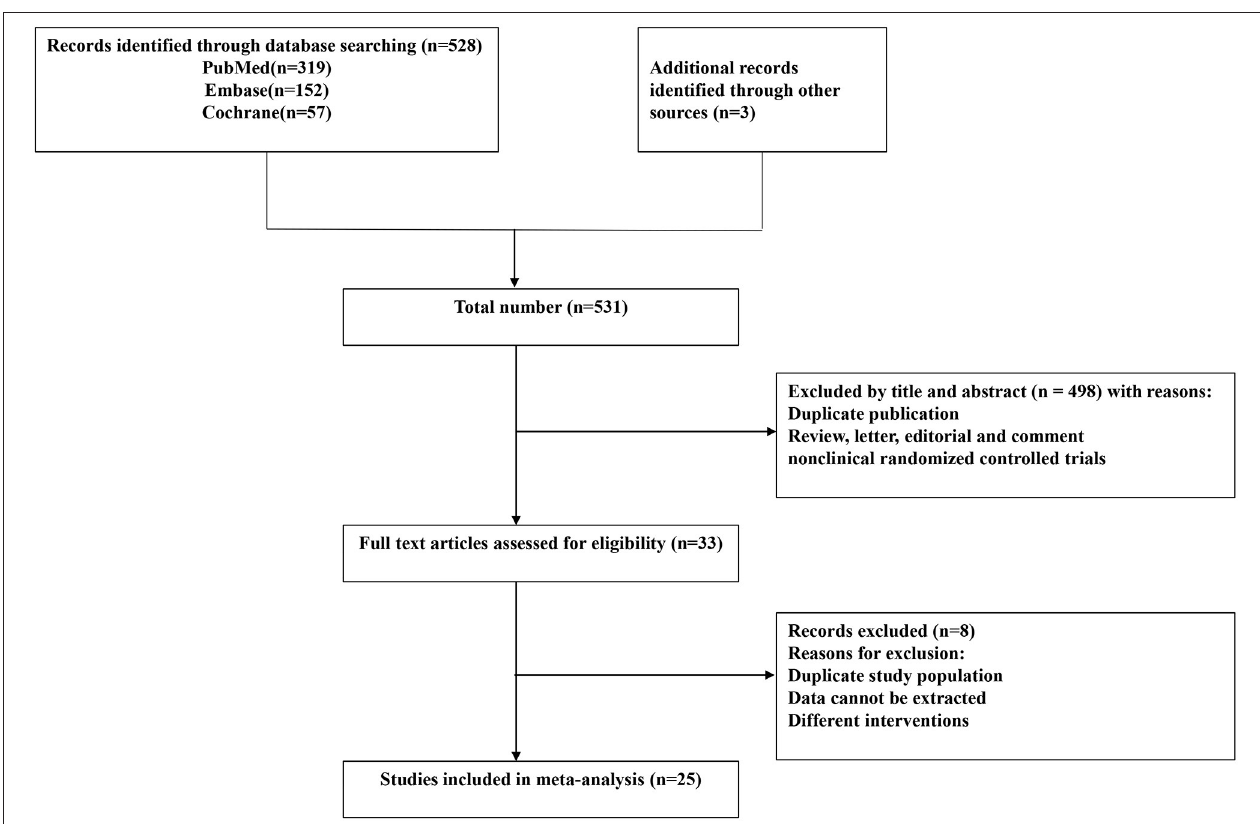
FIGURE 1 | Preferred Reporting Items for Systematic Reviews and Meta-Analyses (PRISMA) flow